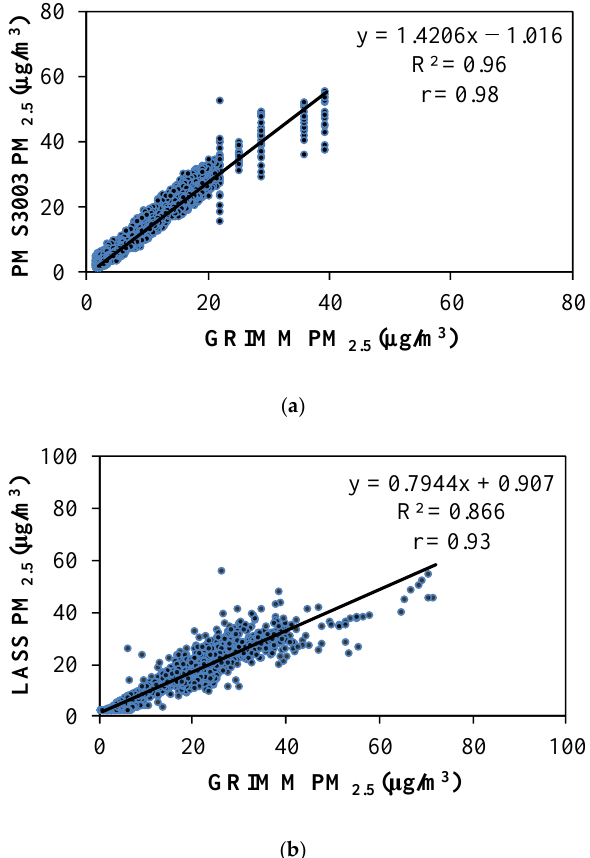
Figure 2. Comparison of GRIMM with ( a ) PM 2.5 of PMS3003 in laboratory ( n = 12,208) and ( b ) PM 2.5 of Location-Aware Sensing System (LASS) observations in field converted by the correction equation shown in ( a ) ( n = 1673); the data presented were 5 min averages.